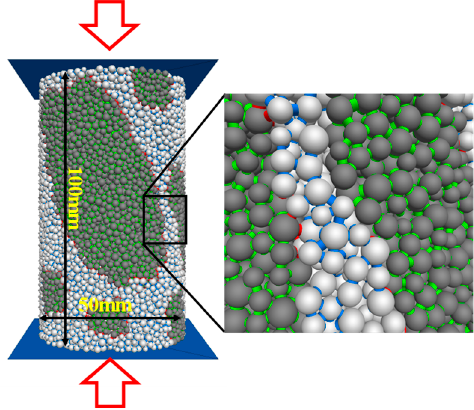
Figure 2. Numerical model of the conglomerate (green represents gravel bond; blue represents matrix bond; red represents cementation surface of gravel and matrix).